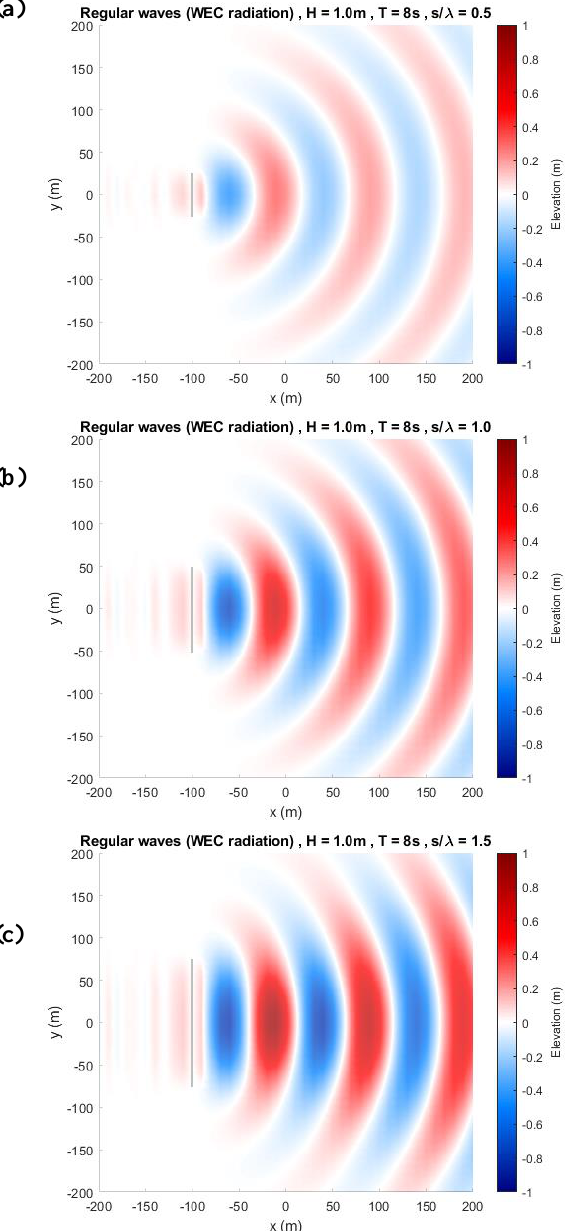
Figure 3: The instantaneous surface elevation for a regular wave for different WEC spans, (a) 𝑠 𝜆⁄ = 0.5 , (b) 𝑠 𝜆⁄ = 1.0 , and (c) 𝑠 𝜆 ⁄ = 1.5